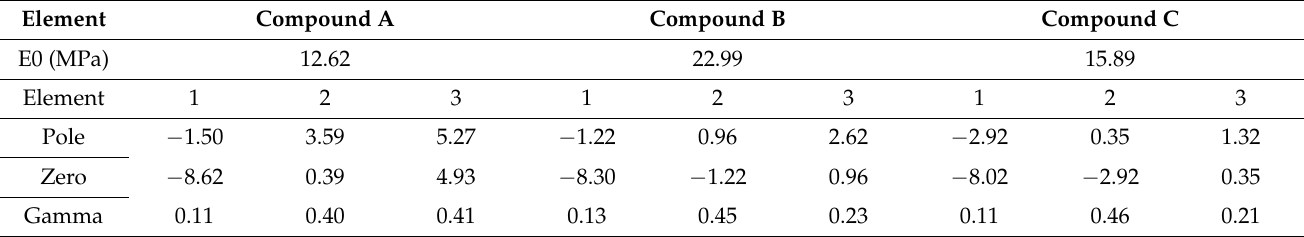
Table A2. Compounds A, B, and C: parameters of FDGM models composed of 3 elements using a reduced number of DMA experimental